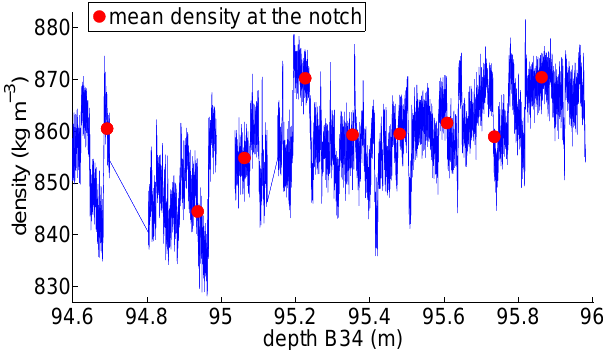
Figure 1. Depth–density profile of the ice core part